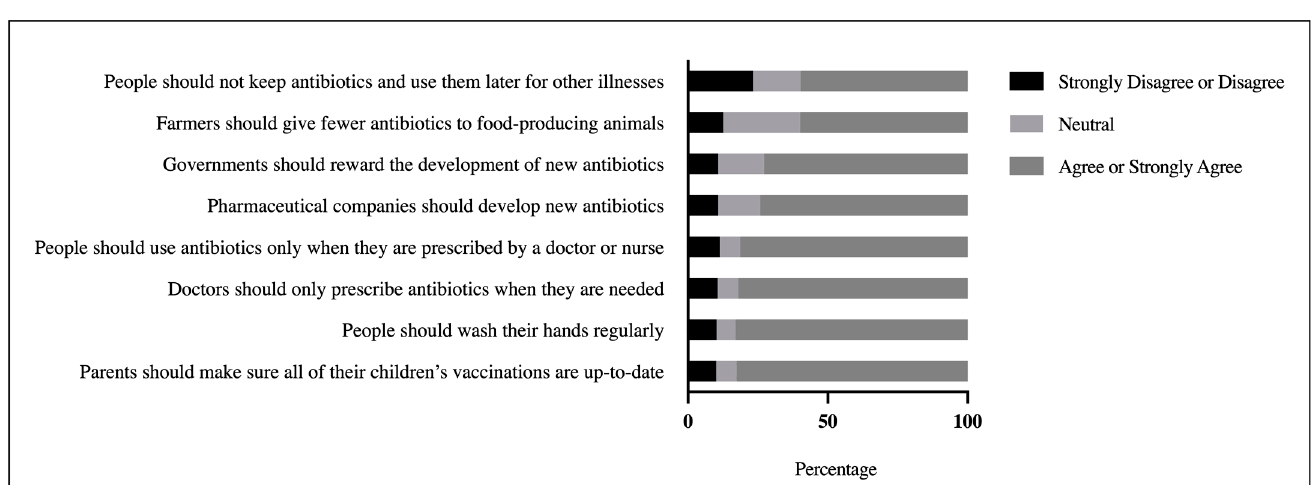
Figure 1. Participants’ awareness of possible solutions to the problem of antibiotic resistance.